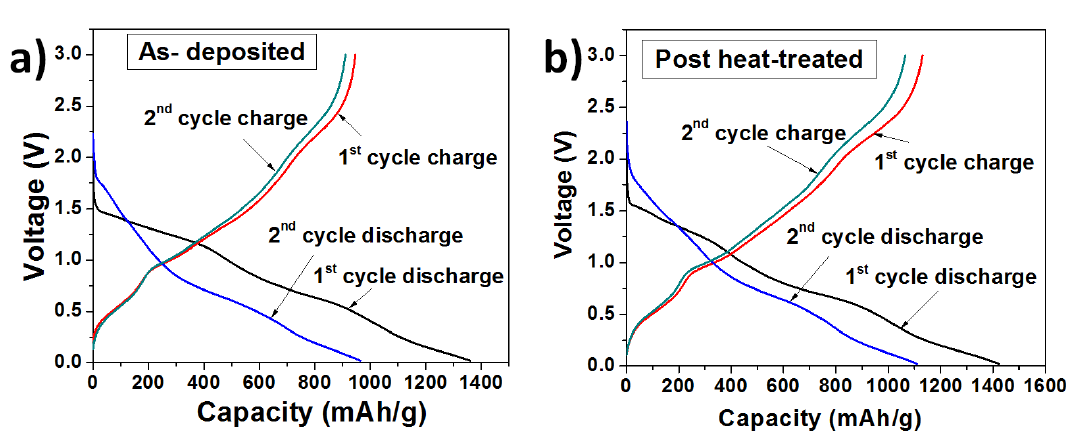
Figure 3. Charge-discharge profiles of ( a ) TG composites at 195 °C (as deposited); and ( b ) TG composites at 280 °C (post-heat treated).